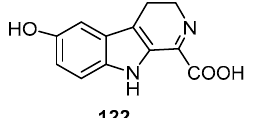
Figure 31. Chemical structure of compound 122 .